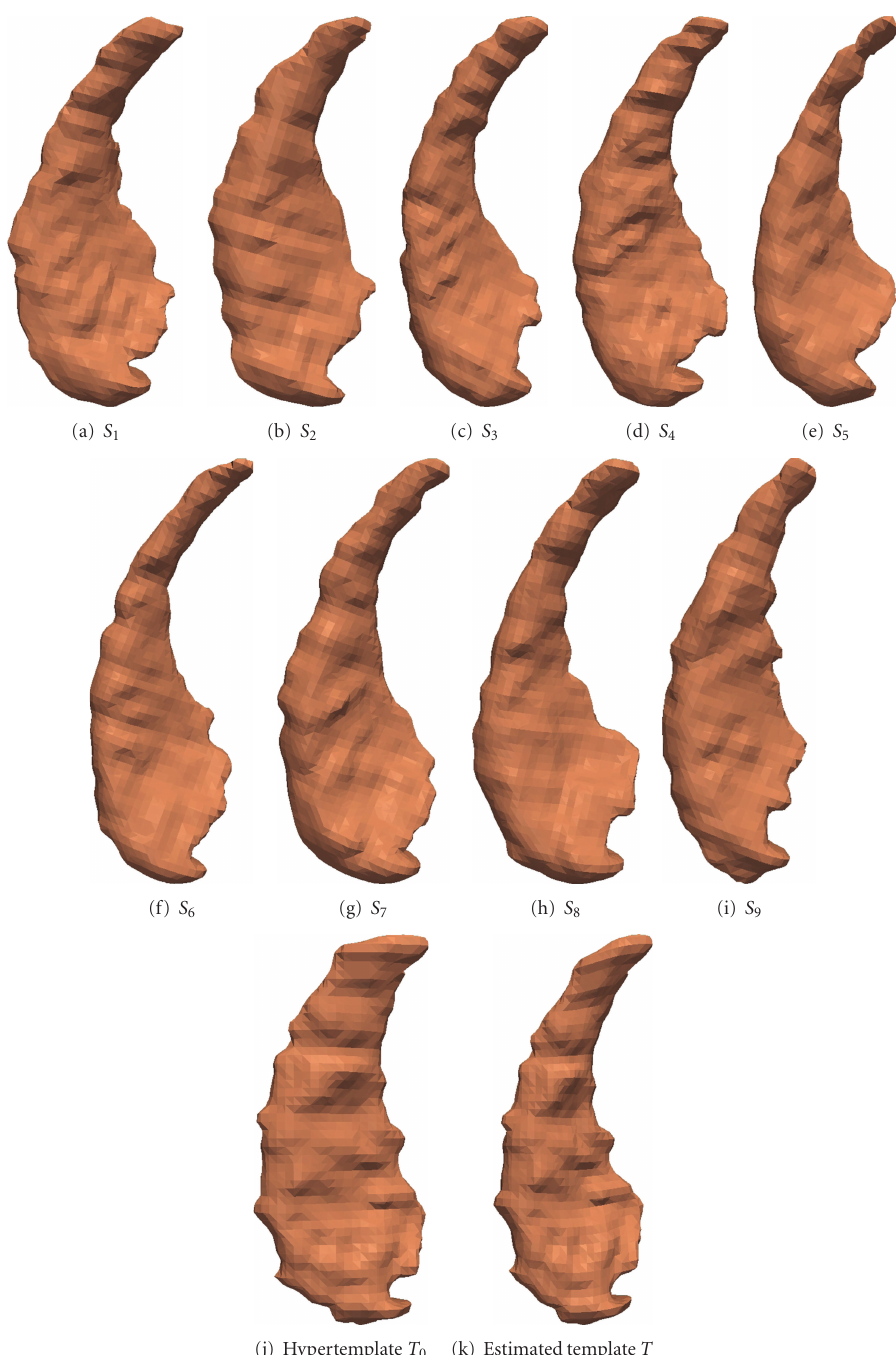
Figure 2: Estimating the surface template from 9 caudate data. (a) − (i) observed surfaces. (j) is the hypertemplate. (k) is the